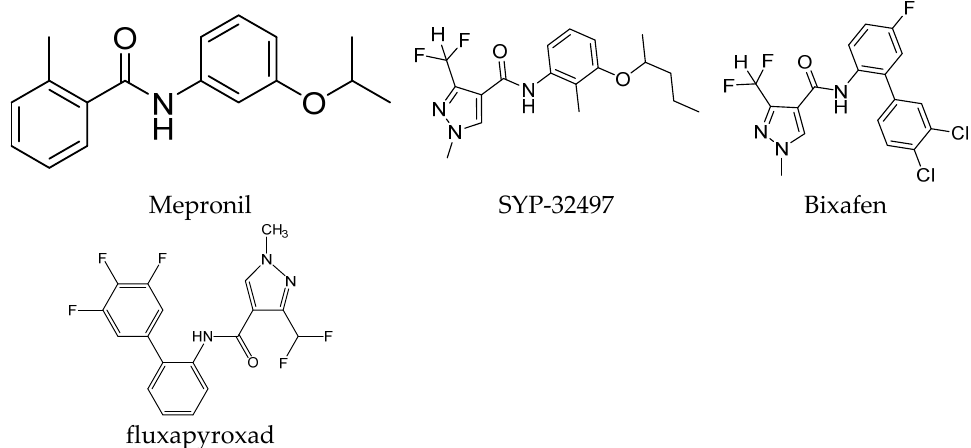
Figure 1. Structures of mepronil, SYP-32497, bixafen, and